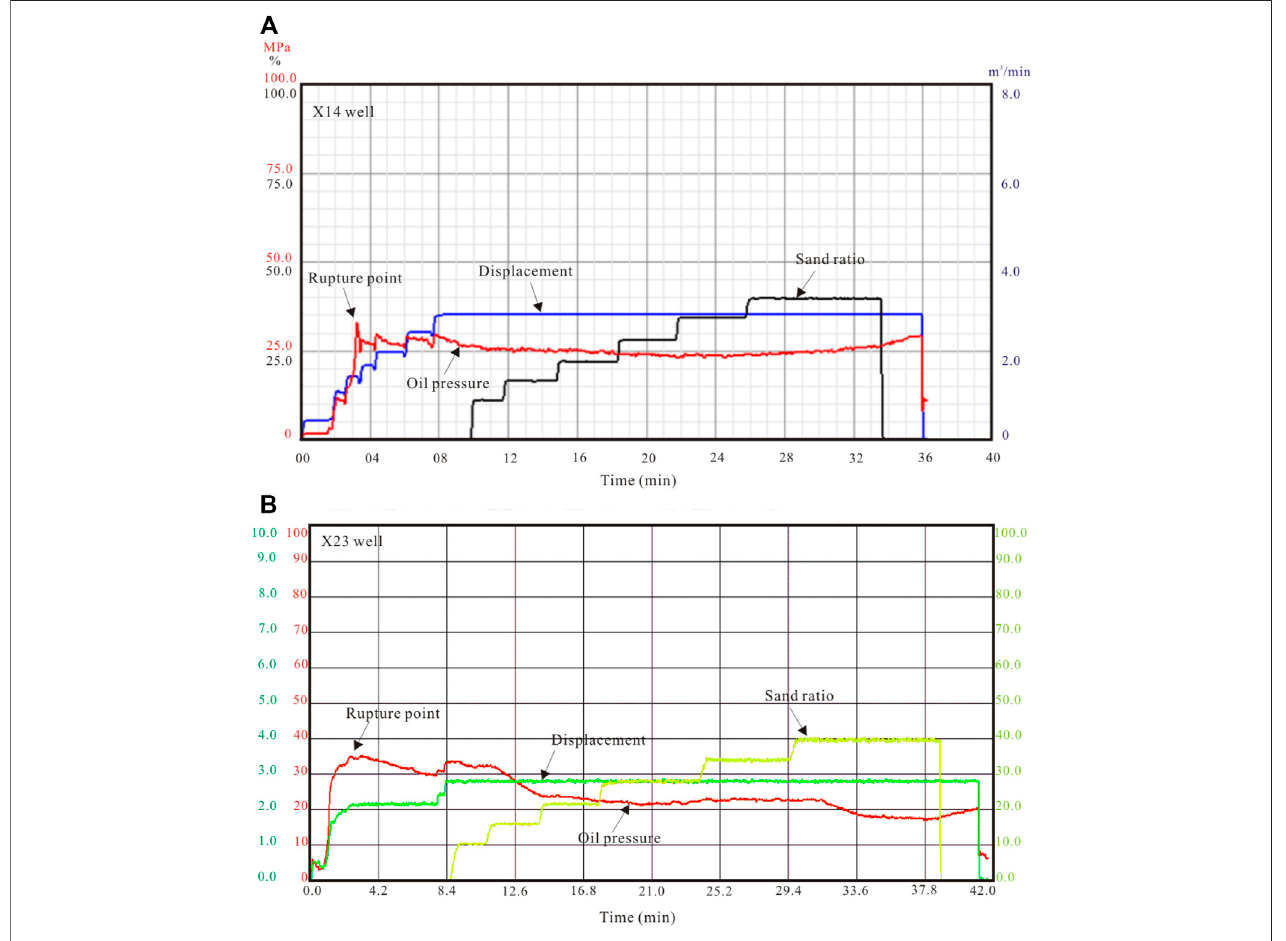
FIGURE 11 | Fracturing construction curves of X14 and X23 wells.